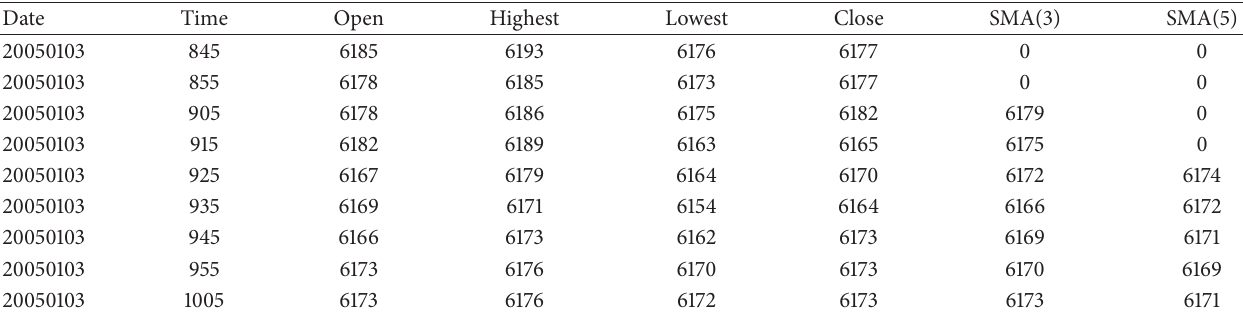
Table 4: 10-minute candlestick chart and SMA indicators.